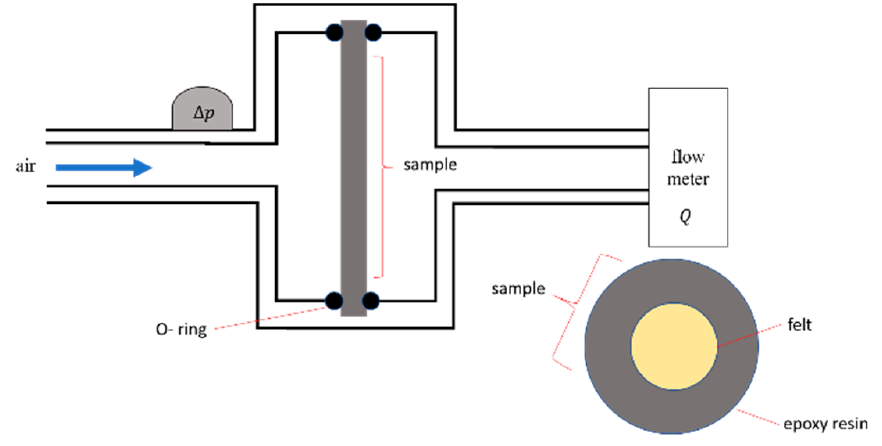
Figure 1. Permeability setup for porous pellet samples.